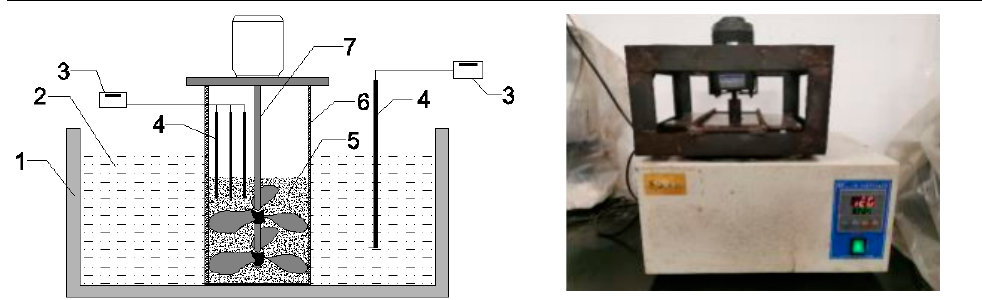
Figure 2. Experimental apparatus for coking coal drying. 1—oil bath, 2—oil, 3—temperature display, 4—temperature and humidity sensor, 5—coking coal, 6—stainless steel container, and 7— stirrer.